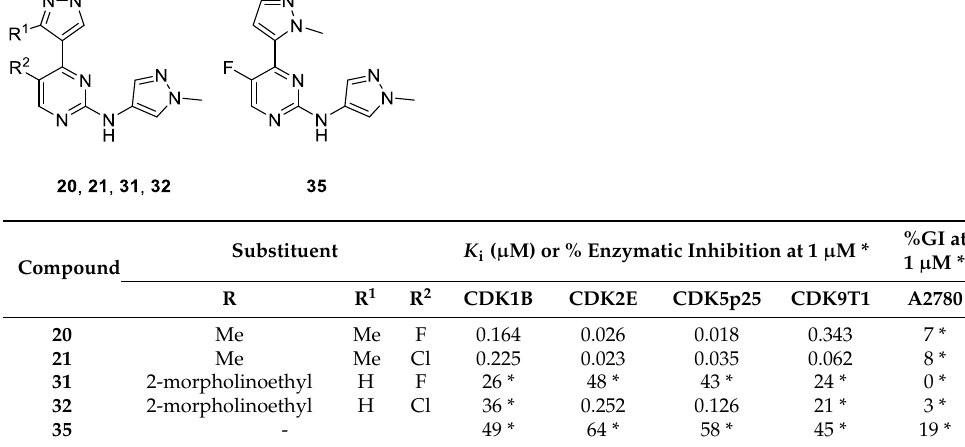
Table 2. Inhibition of CDK kinase activity and A2780 cell viability by 20 , 21 , 31 , 32 , and 35 .